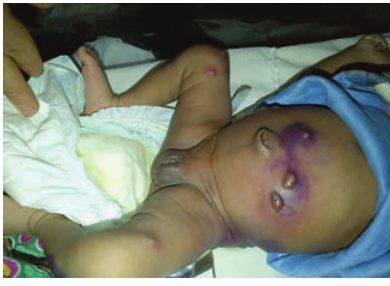
Figure 1. Furruncles on anterior abdomi- nal wall and thighs.